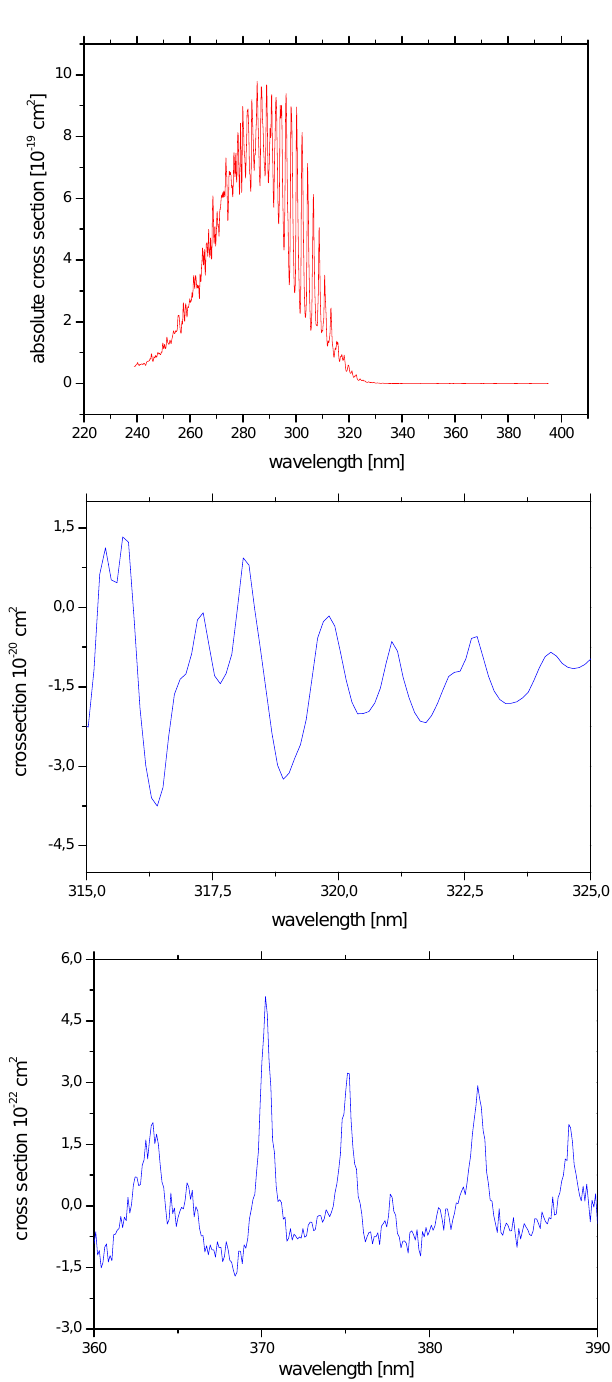
Fig. 4. SO 2 cross section for 273K from Bogumil et al. (2003) (a) absolute cross section, (b) Differential cross section high pass filtered for the wavelength range 315–325nm (c) Differen- tial cross section high pass filtered for the wavelength range 360– 390nm. The differential absorption cross sections are ≈ 4 . 5 × 10 − 20 cm 2 /molec and 6 × 10 − 22 cm 2 /molec for the short wave UV and long wave UV regions,